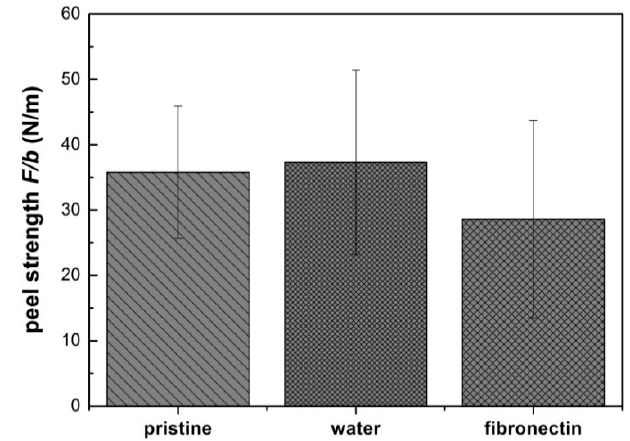
Figure 6. Maximum strength during peel test (F/b) of composite films on a rough glass substrate. (F/b): F indicates the peel force; b indicates the width of the film (0.5 cm). Three conditions were investigated: pristine, stored in ddH 2 O, and coated with fibronectin. The polymeric films were cut into small